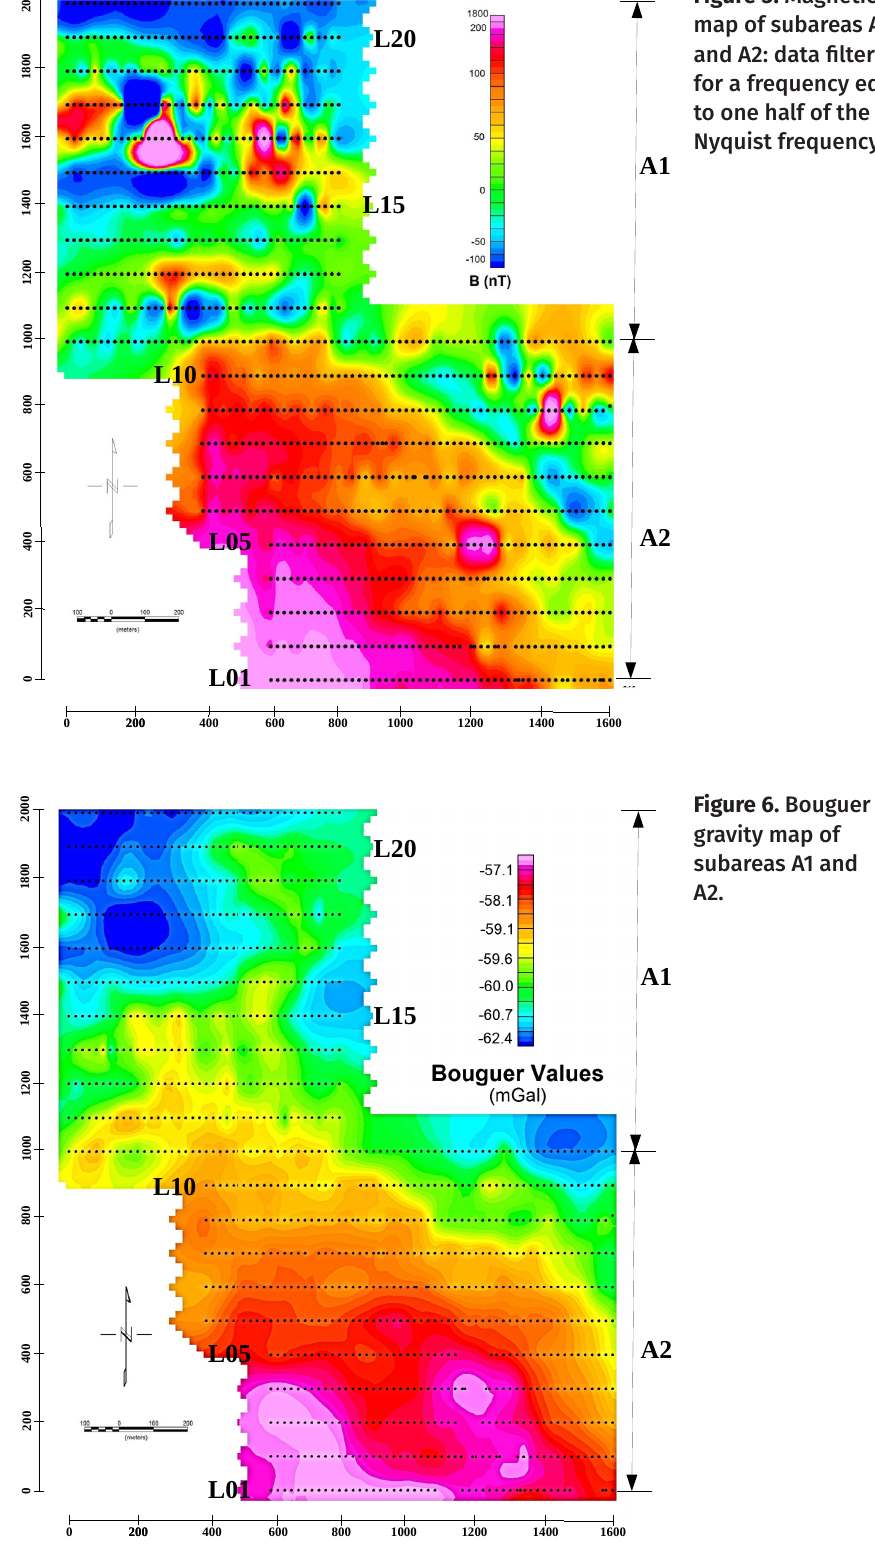
Figure 5. Magnetic map of subareas A1 and A2: data filtered for a frequency equal to one half of the Nyquist